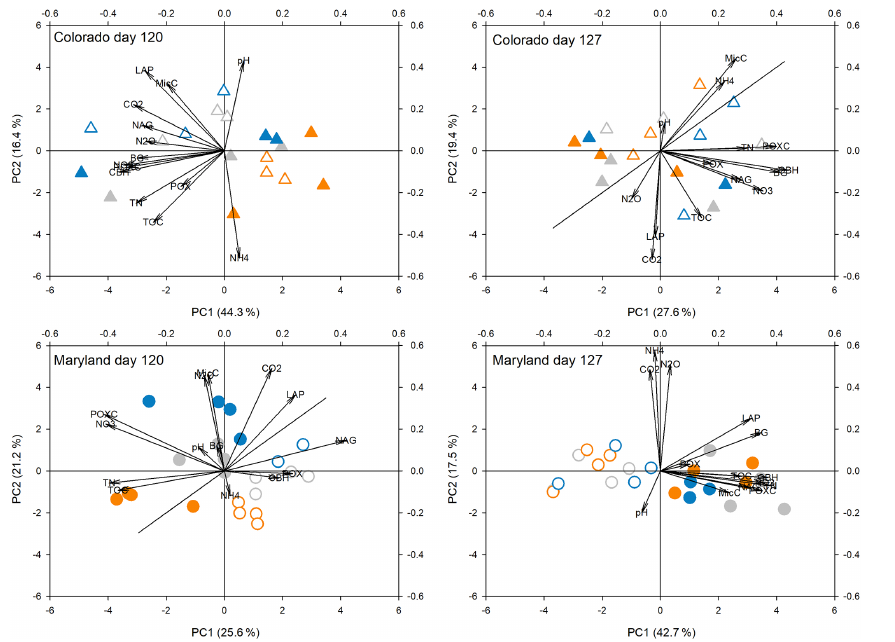
Figure 5. Principal components analysis of all response parameters at the fifth peak stress (day 120) and following the fifth stress (day 127) in soils from Colorado and Maryland. Blue symbols are the flooding treatment and orange symbols are the drought treatment. Gray symbols are the control. Open symbols represent simple and filled symbols represent complex rotations. Significant differences between treatments along the axes are shown in Table 2. Included parameters are pH, extractable organic carbon (EOC), total extractable nitrogen (TEN), microbial biomass carbon (MBC), NH 4 , NO 3 , activities of β -glucosidase (BG), cellobiohydrolase (CBH), N-acetyl-glucosaminidase (NAG), leucine-amino-peptidase (LAP), phenoloxidase (POX) and peroxidase (PEX), respiration (CO 2 ), N 2 O production (N 2 O), and permanganate oxidizable carbon